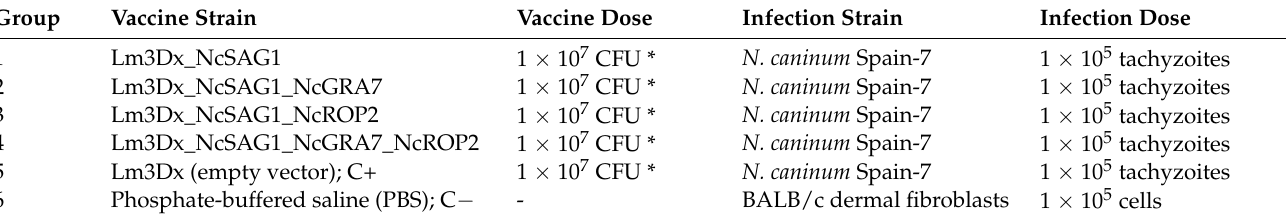
Table 1. Experimental groups ( n = 16) for the evaluation of the mutant Listeria vaccine strains. Group Vaccine